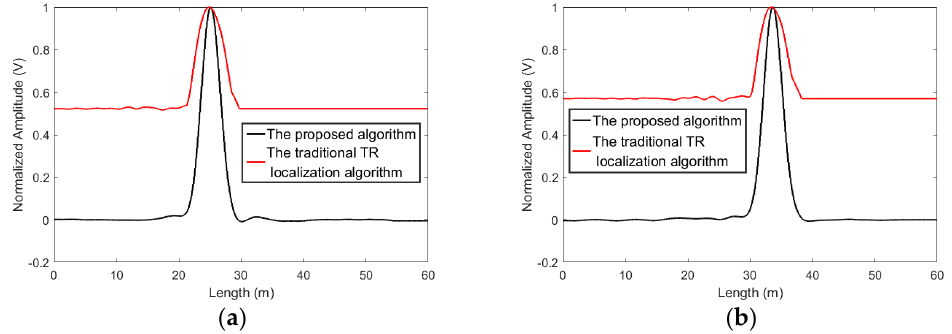
Figure 4. The localization results obtained by using the proposed algorithm and the traditional time reversal localization algorithm based on the maximum of the time reversed signal. ( a ) L1 and ( b ) L2.